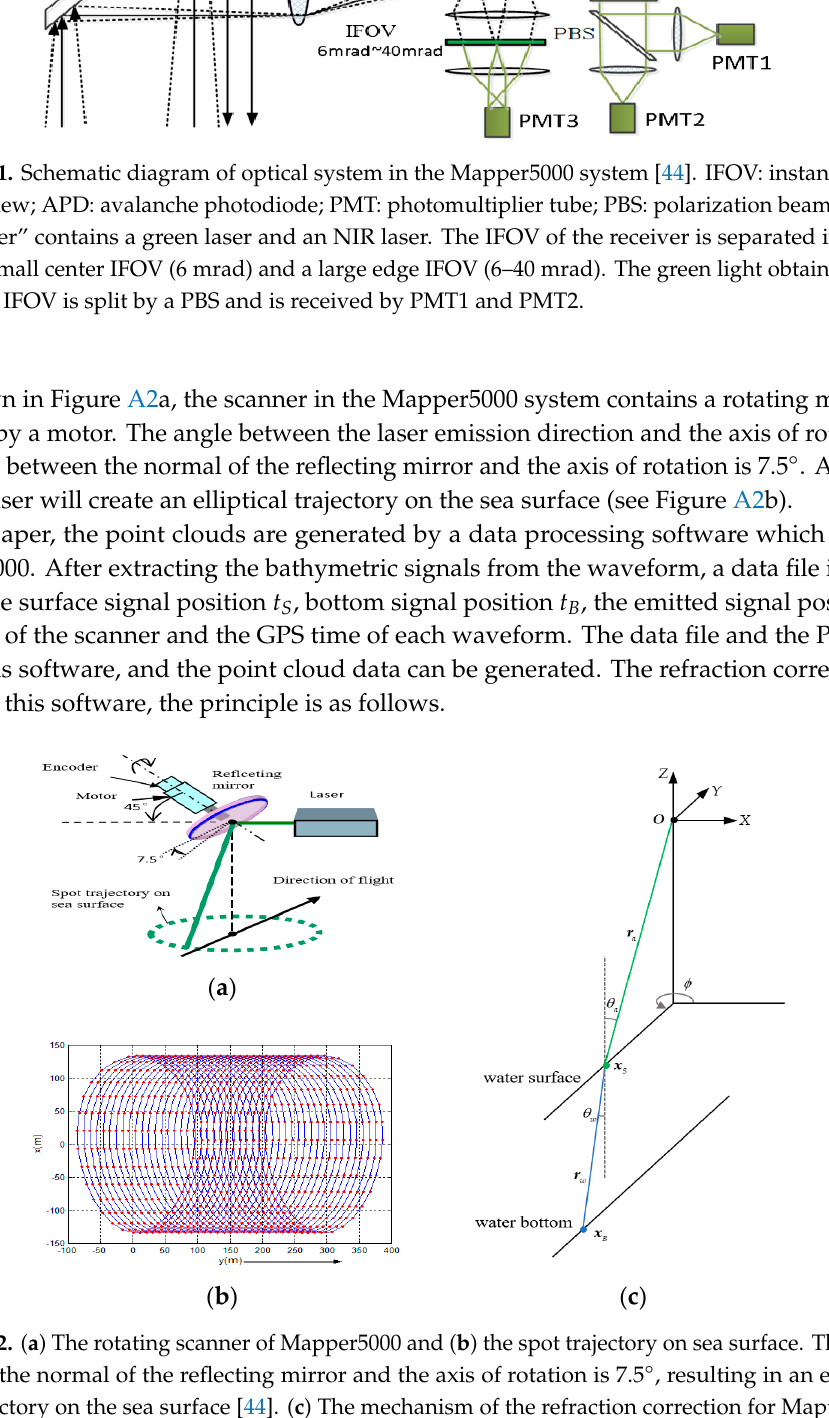
Figure 22. Comparison between the real waveforms and the simulated waveforms with depths of ( a ) 0.8 m and ( b ) 27 m.